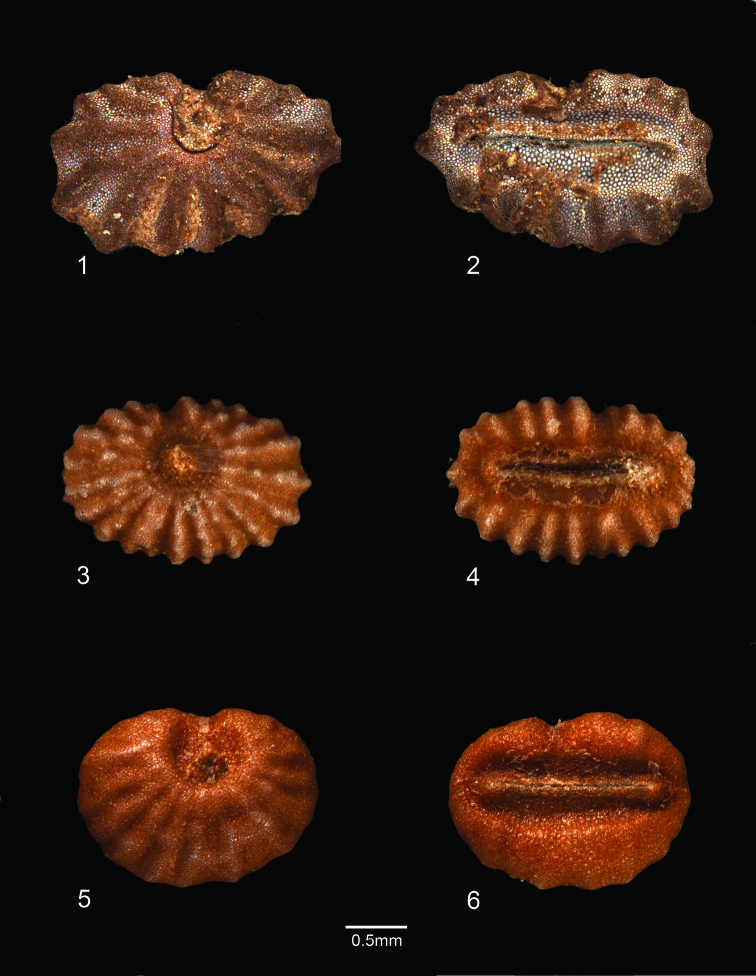
Seeds of Polyspatha species 1–2 Polyspatha paniculata Benth. 1 Seed, dorsal view 2 Seed, ventral view. (From Faden et al. 74/35 from Ghana, cultivated at Smithsonian Institution) 3–4 Polyspatha oligospatha Faden, sp. nov. 3 Seed, dorsal view. 4. Seed, ventral view. (From de Wilde & de Wilde-Duyfjes 2647 [BR] from Cameroon) 5–6 Polyspatha hirsuta Mildbr. 5 Seed, dorsal view 6 Seed, ventral view. (From Kahn 92-1 [US] from Cameroon).